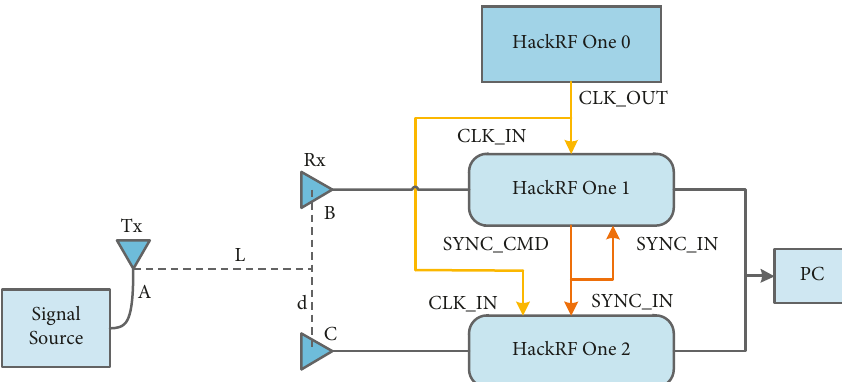
Figure 9: Diagram of synchronization error experiment.